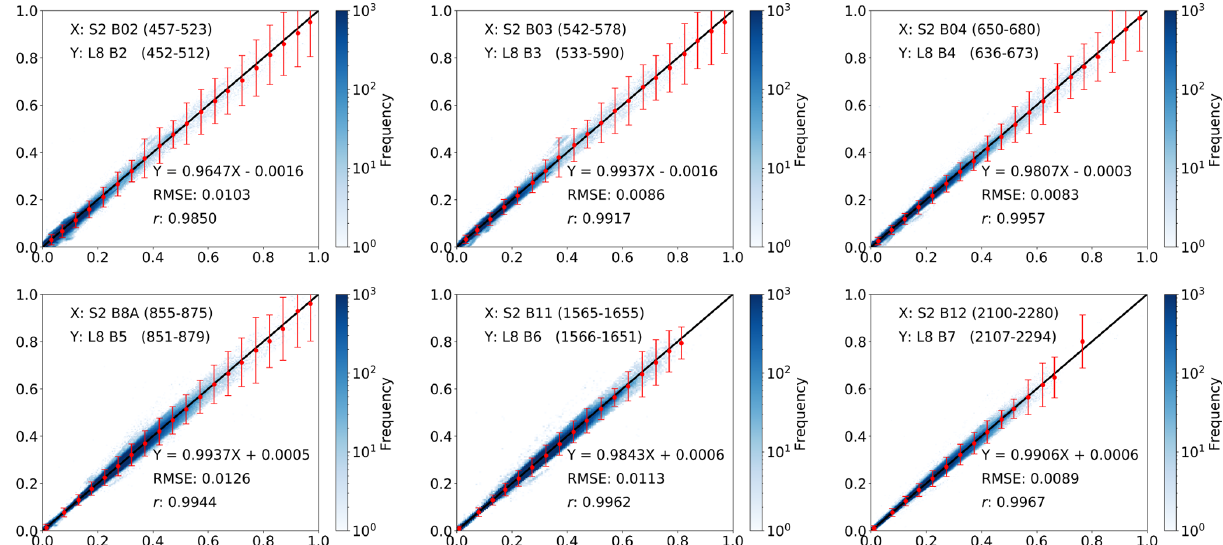
Figure 8. 2D histogram of surface reflectance after the atmospheric correction from 3466 S2 and L8 near simultaneous observations; each subplots shows the results for the closest S2 and L8 bands. The colour bar is shown using a logarithmic scale. The error bars are 3 σ of the difference between the S2 and L8 corrected reflectance, which is computed at an interval of 0.05 from